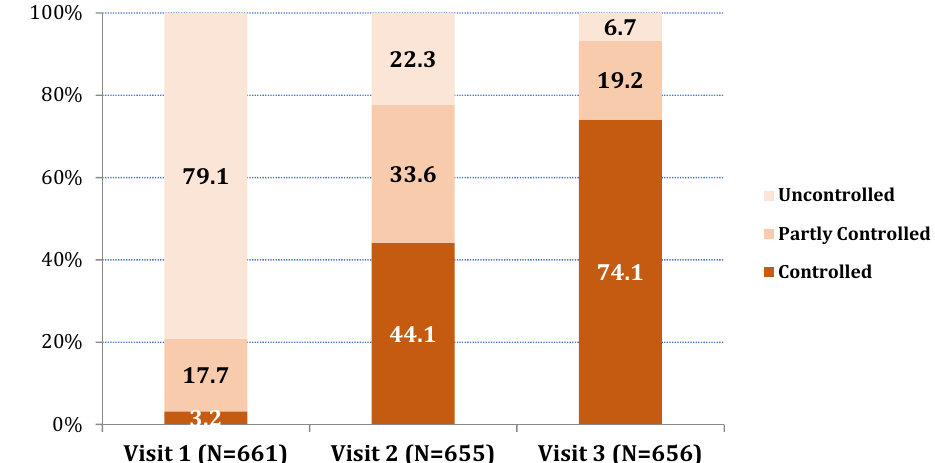
Figure 2. ACQ-6 classification (%) for the three visits of the study.